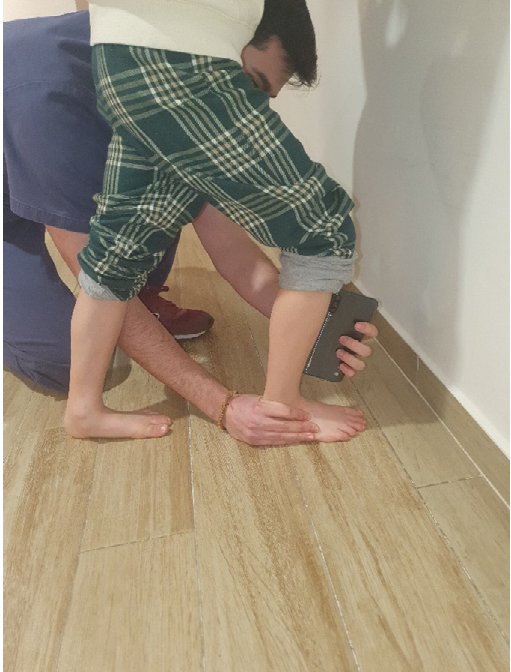
Figure 1. Assessment of range of ankle dorsiflexion by the Ankle Lunge